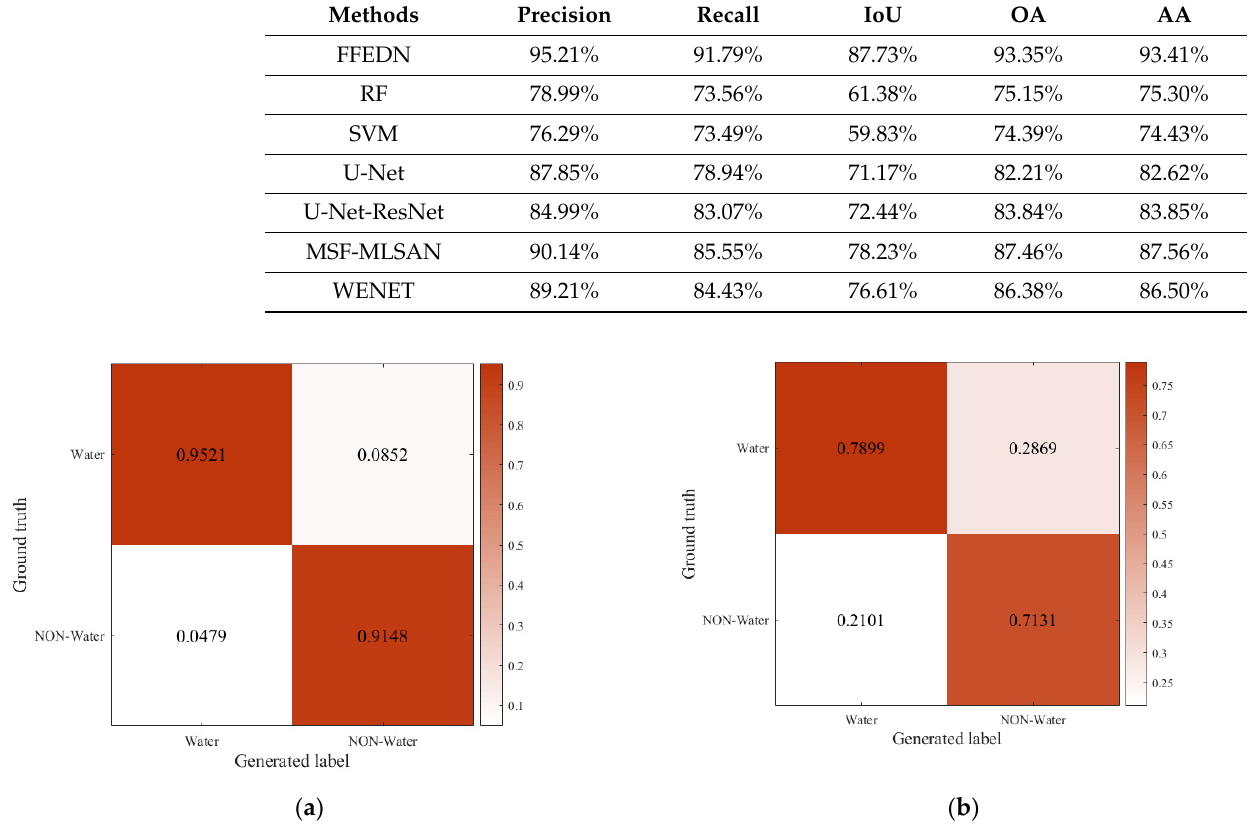
Figure 13. The extraction results of different methods. ( a1 )–( a3 ) FFEDN. ( b1 )–( b3 ) RF. ( c1 )–( c3 ) SVM. ( d1 )–( d3 ) U-Net. ( e1 )–( e3 ) U-Net-ResNet. ( f1 )–( f3 ) MSF-MLSAN. ( g1 )–( g3 ) WENET.